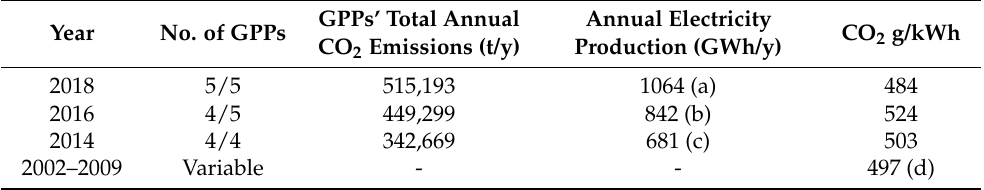
Table 4. Mt. Amiata GPPs’ CO 2 emissions. Number of GPPs sampled by ARPAT compared to the total installed. Total CO 2 emissions from GPPs are computed after ARPAT inventories [13,58]; 2016 data are after [57,60]. Annual electricity production for Mt. Amiata GPPs data after: (a) [55]; (b) [60]; (c) [61]. (d) CO 2 emission factor years 2002–2009 after